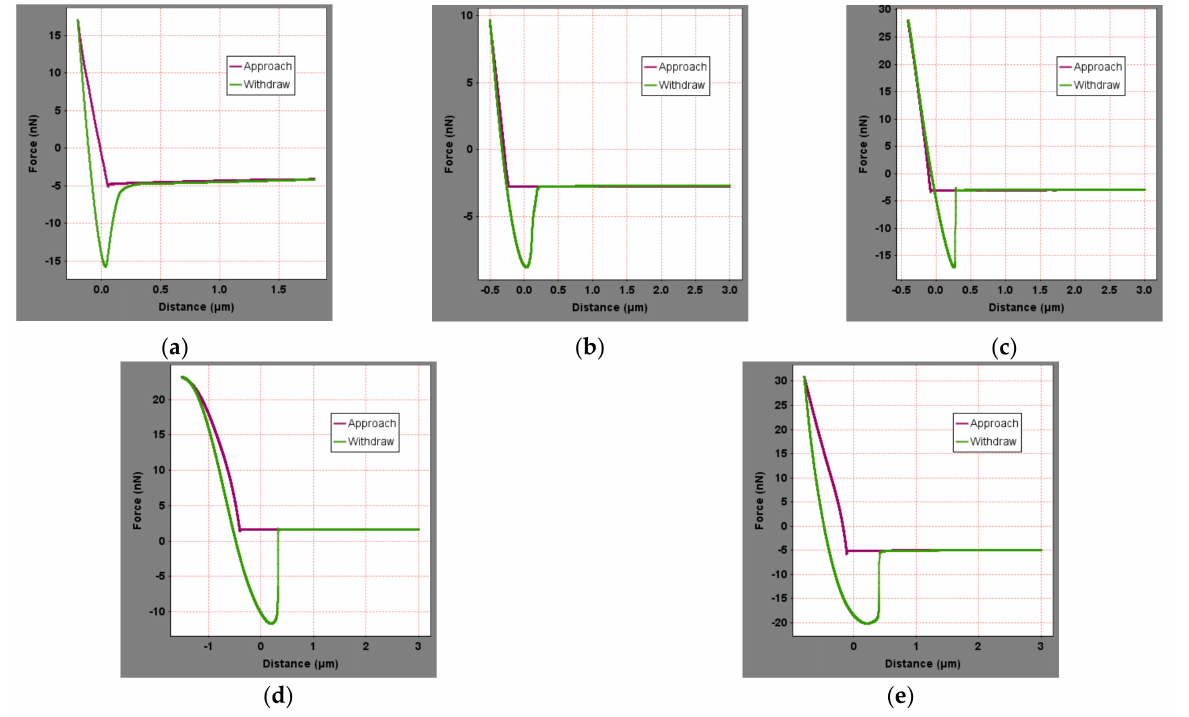
Figure 10. Force curves of asphalt binder after water-immersed: ( a ) SK-70, ( b ) KL-70, ( c ) Shell-70, ( d ) SK-90, and ( e )